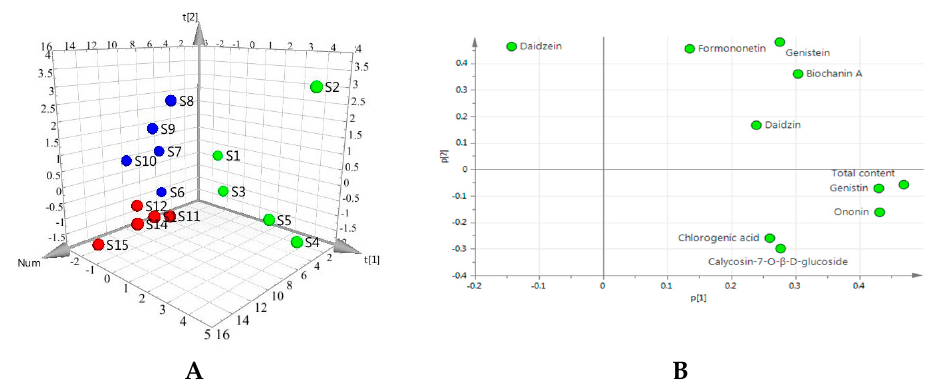
Figure 4. Principal component snalysis. ( A ): Three-dimensional (PCA 3D) score plots using the contents of the nine compounds and the total contents. S1–S5 (green), samples from Gansu; S6–S10 (blue), samples from Hubei; S11–S15 (red), samples from Shanxi. ( B ): Loadings scatter plot.